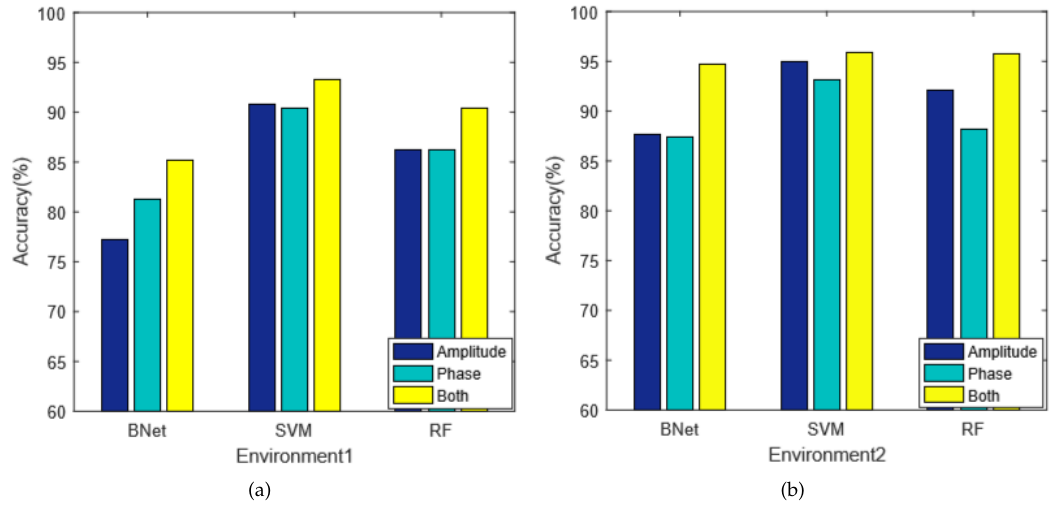
Figure 10. The amplitude/phase selection on classification accuracy.